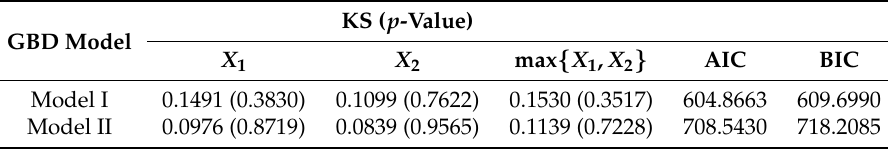
Table 2. Goodness-of-fit results for UEFA Champion’s League